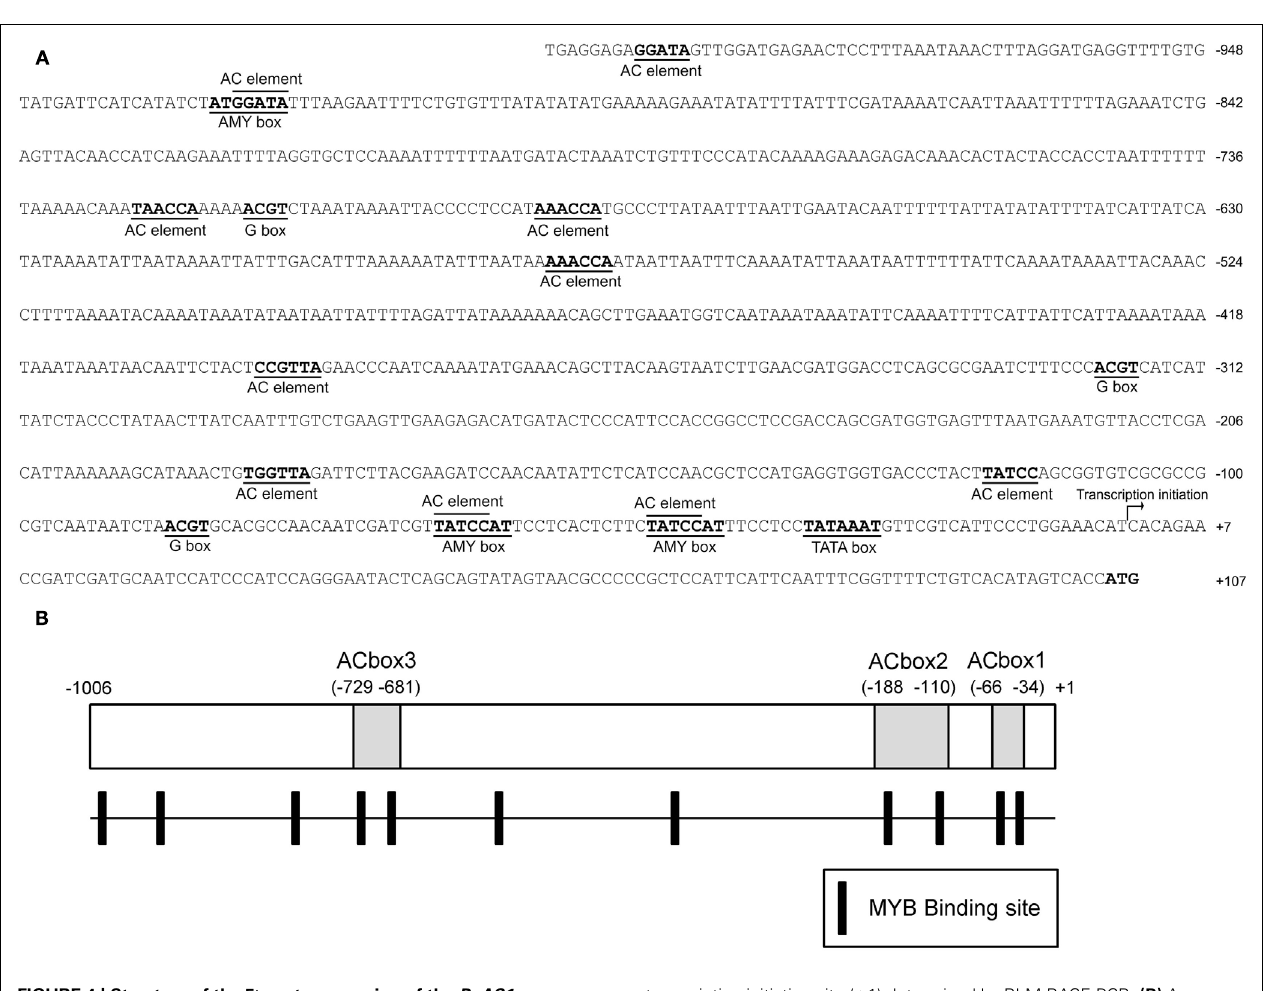
FIGURE 4 | Structure of the 5 (cid:2) upstream region of the PpAS1 gene. (A) The full-length sequence of the isolated promoter.The location of consensus sequences for putative regulatory elements is indicated over the nucleotide sequence. Numeration is referred to the